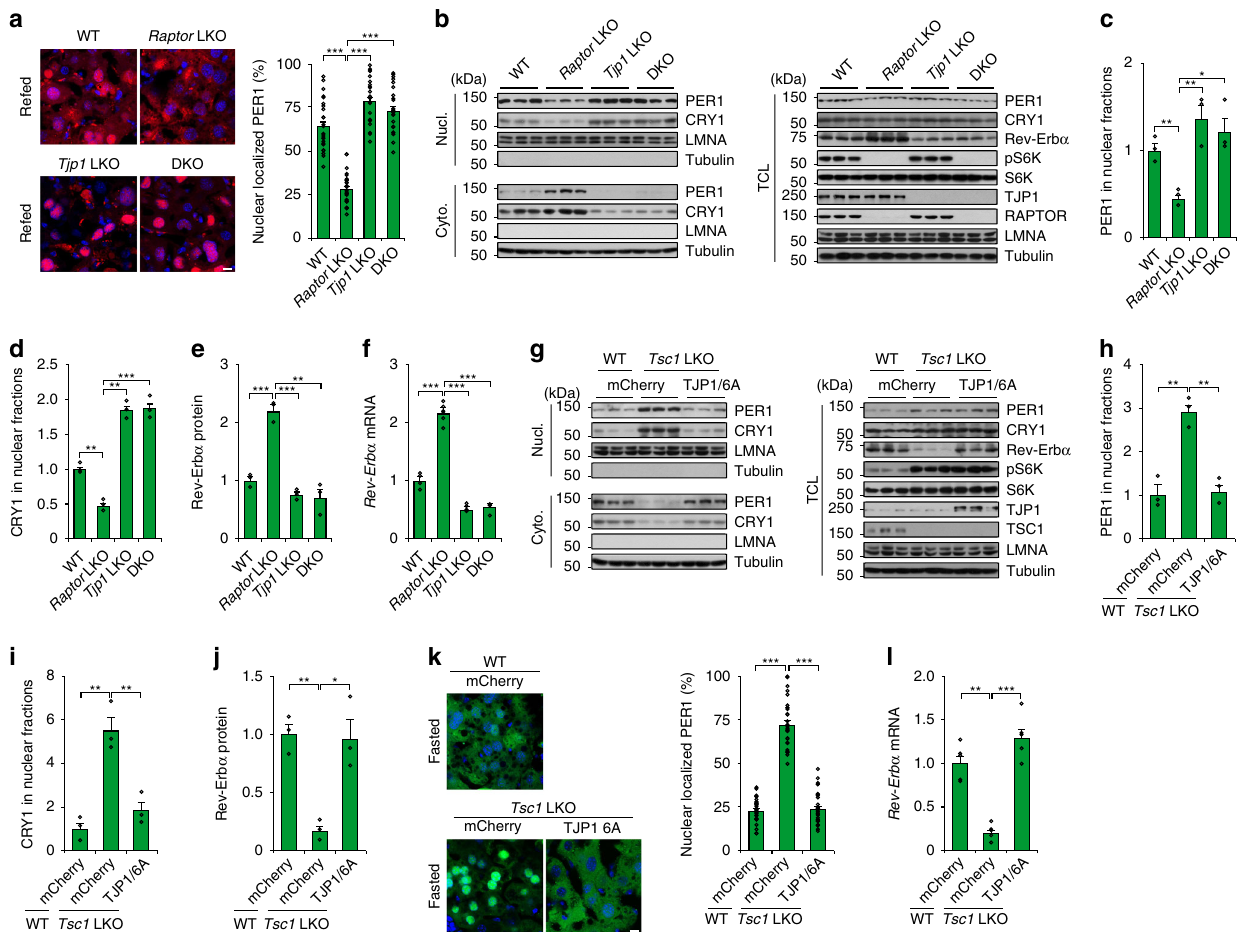
Fig. 6 TJP1 regulates the feeding-induced effect of mTOR on the circadian clock. a and b Cellular localization of mCherry-PER1 in the liver a and immunoblots showing the amount of PER1 b in liver extracts from WT, Raptor LKO, Tjp1 LKO, and Raptor / Tjp1 double knockout (DKO) fed mice. n = 4 – 6 mice. c – e Statistical analysis of PER1 c and CRY1 d in Nucl. and Rev-Erb α in TCL e from immunoblots as shown in b . n = 4 – 6 mice. f qPCR results showing Rev-Erb α expression in liver extracts from WT, Raptor LKO, Tjp1 LKO, and Raptor / Tjp1 double knockout (DKO) fed mice. n = 4 – 6 mice. g – j Effect of Tsc1 LKO and addition of TJP1/6A on PER1 level in the nuclear fraction g , and statistical analysis of PER1 h and CRY1 i in Nucl. and Rev-Erb α in TCL j from immunoblots as shown in g in liver extracts from WT, Tsc1 LKO, and mCherry-TJP1/6A-overexpressing mice after overnight fasting. n = 5 mice. k and l Effect of Tsc1 LKO and addition of TJP1/6A on cellular localization of GFP-PER1 in the liver k and Rev-Erb α expression l in liver extracts from WT, Tsc1 LKO, and mCherry-TJP1/6A-overexpressing mice after overnight fasting. n = 5 mice. Scale bars, 10 μ m. Data are shown as mean ± s.e.m. Comparison of different groups was carried out using one-way ANOVA. *P < 0.05, **P < 0.01, ***P < 0.001. Source data are provided as a Source Data fi